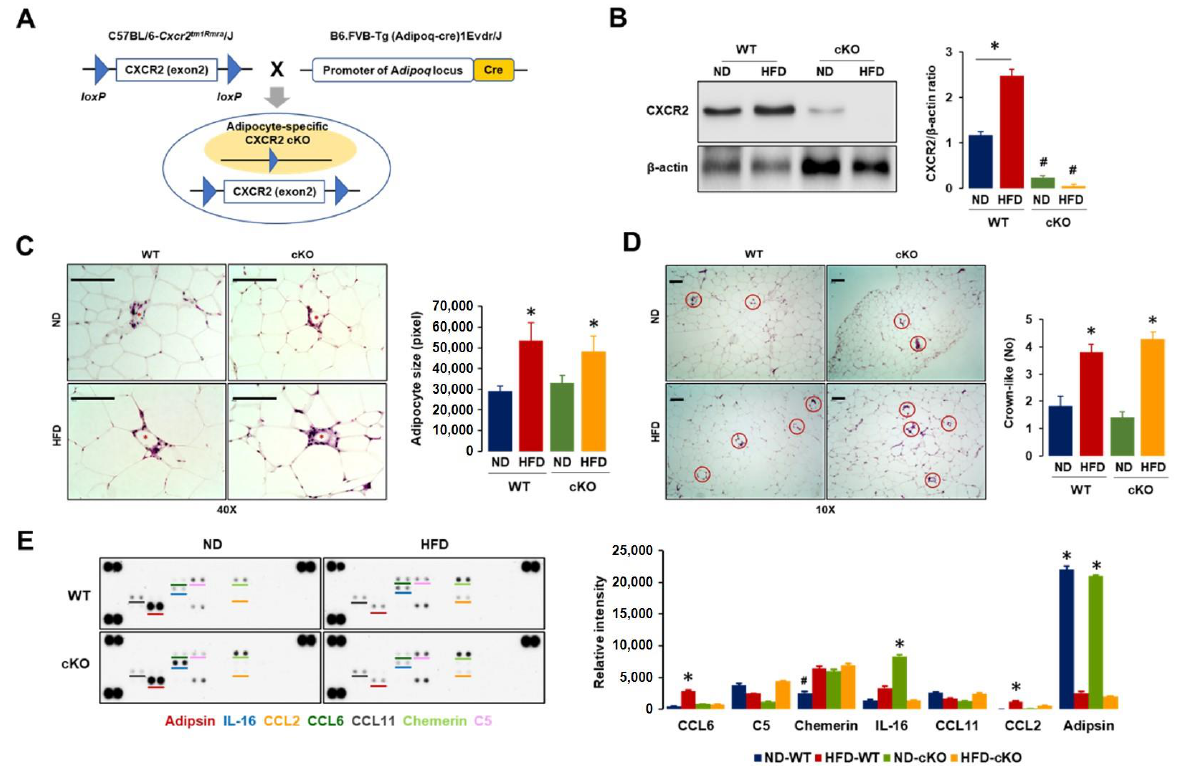
Figure 1. Generation of adipocyte-specific CXCR2 cKO mice and characteristics of adipose tissues in ND-WT, ND-cKO, HFD-WT, and HFD-cKO mice. ( A ) Generation of adipocyte-specific CXCR2 cKO mice by crossing C57BL/6- Cxcr2 tm1Rmra /J (JAX #024638) with B6.FVB-Tg (Adipoq-cre)1Evdr/J (JAX #028020). ( B ) Confirmation of CXCR2 protein levels in perigonadal adipose tissues from ND-WT, ND-cKO, HFD-WT, and HFD-cKO mice without tumors. The image shown is representative of triplicate experiments. ( C ) Comparison of adipocyte size in perigonadal adipose tissues from ND-WT, ND-cKO, HFD-WT, and HFD-cKO mice. Red asterisks indicate crown-like structures and area measurement was calculated from 100 random adipocytes with ImageJ. ( D ) Comparison of crown-like structures in perigonadal adipose tissues from ND-WT, ND-cKO, HFD-WT, and HFD-cKO mice. Red circles mark crown-like structures; data were obtained from 10 random fields under microscope. ( E ) Comparison of chemokine/cytokine signature in perigonadal adipose tissues from ND-WT, ND-cKO, HFD-WT, and HFD-cKO mice by Proteome Profiler Mouse Chemokine Array ( n = 3). Bars and error bars refer to mean and SEM. * and # indicates a significant increase and decrease ( p ≤ 0.05), respectively, as determined by ANOVA and Tukey’s pairwise comparison .